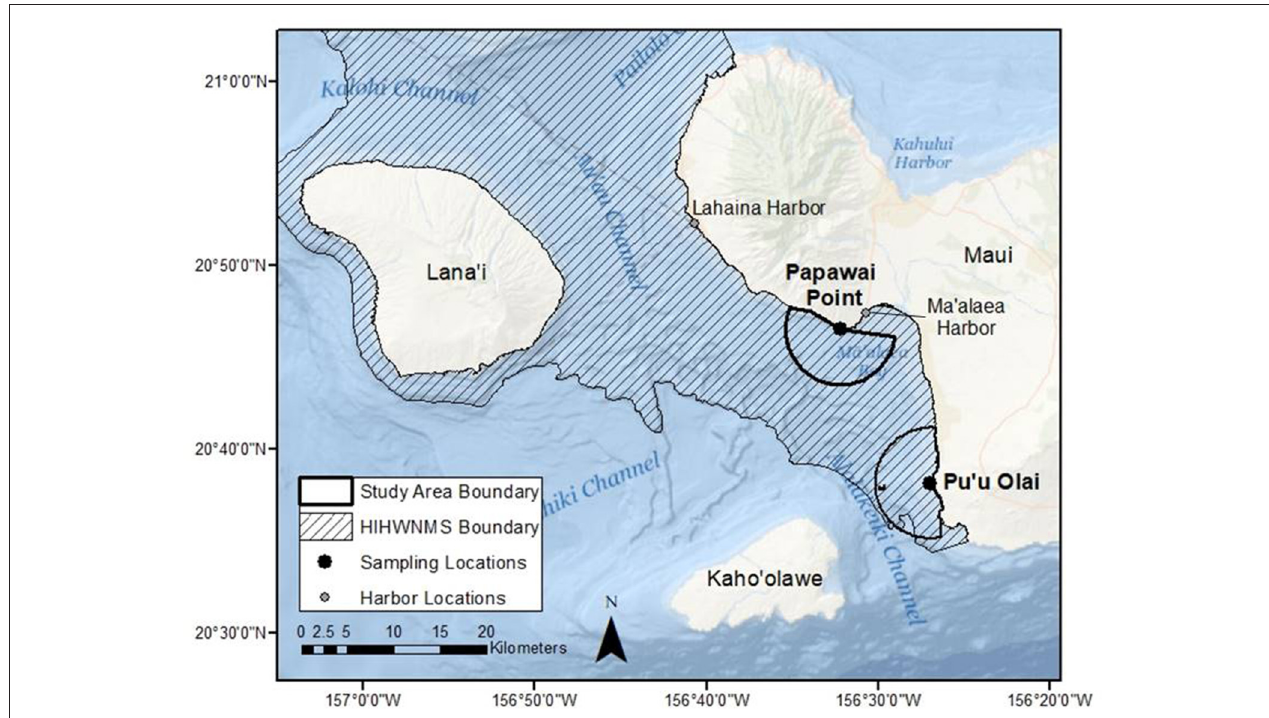
FIGURE 1 | Map depicting the survey area boundaries of the two land-based sites used to observe humpback whale behavior from 2015 to 2018 as well as the extent of the Hawaiian Islands Humpback Whale National Marine Sanctuary (HIHWNMS) in Maui Nui, Hawai’i. Ocean Basemap Source: Esri, GEBCO, NOAA, National Geographic, DeLorme, HERE, Geonames.org, and other